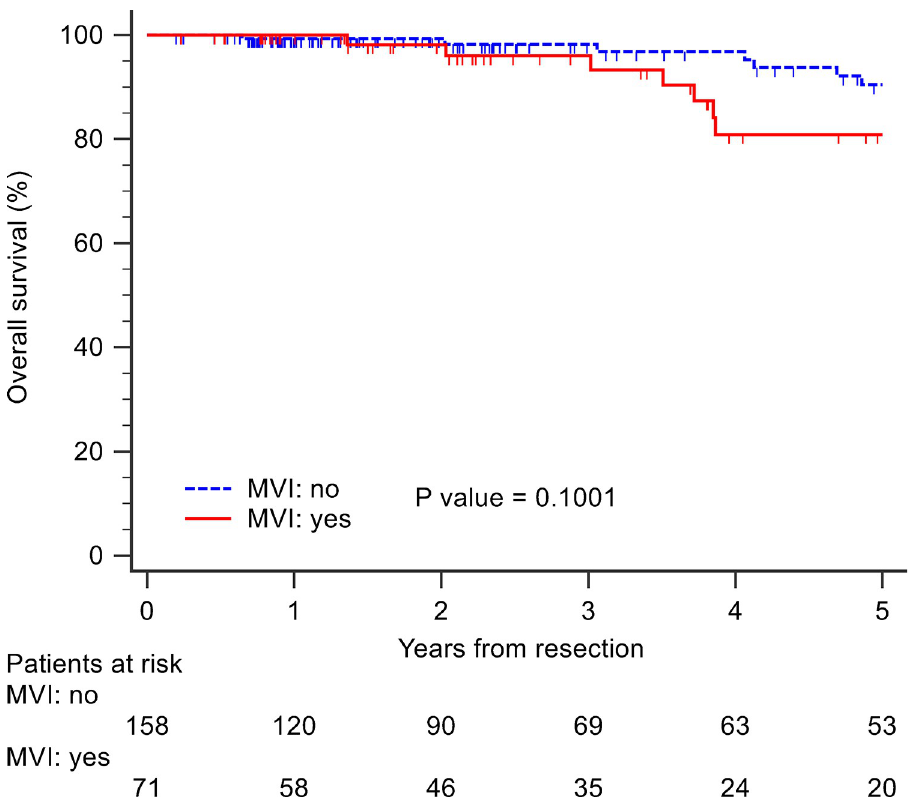
Fig 1. Overall survival of patients with solitary hepatocellular carcinoma according to presence of microvascular invasion (MVI).